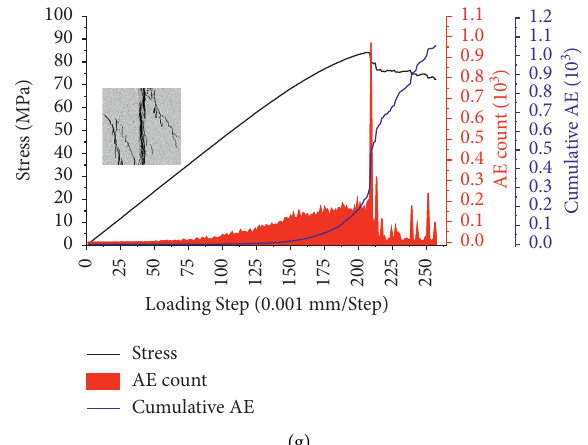
Figure 11: Trends of stress, AE energy, and cumulative AE energy with loading step at different azimuth angles. (a)–(g) represent specimens 0 ° , 15 ° , 30 ° , 45 ° , 60 ° , 75 ° , and 90 ° , respectively.